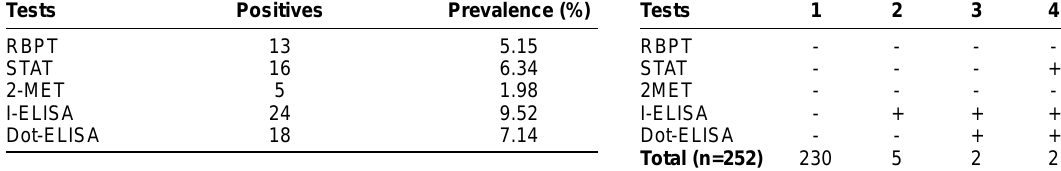
Table-3: Relative sensitivity and specificity with I-ELISA as reference